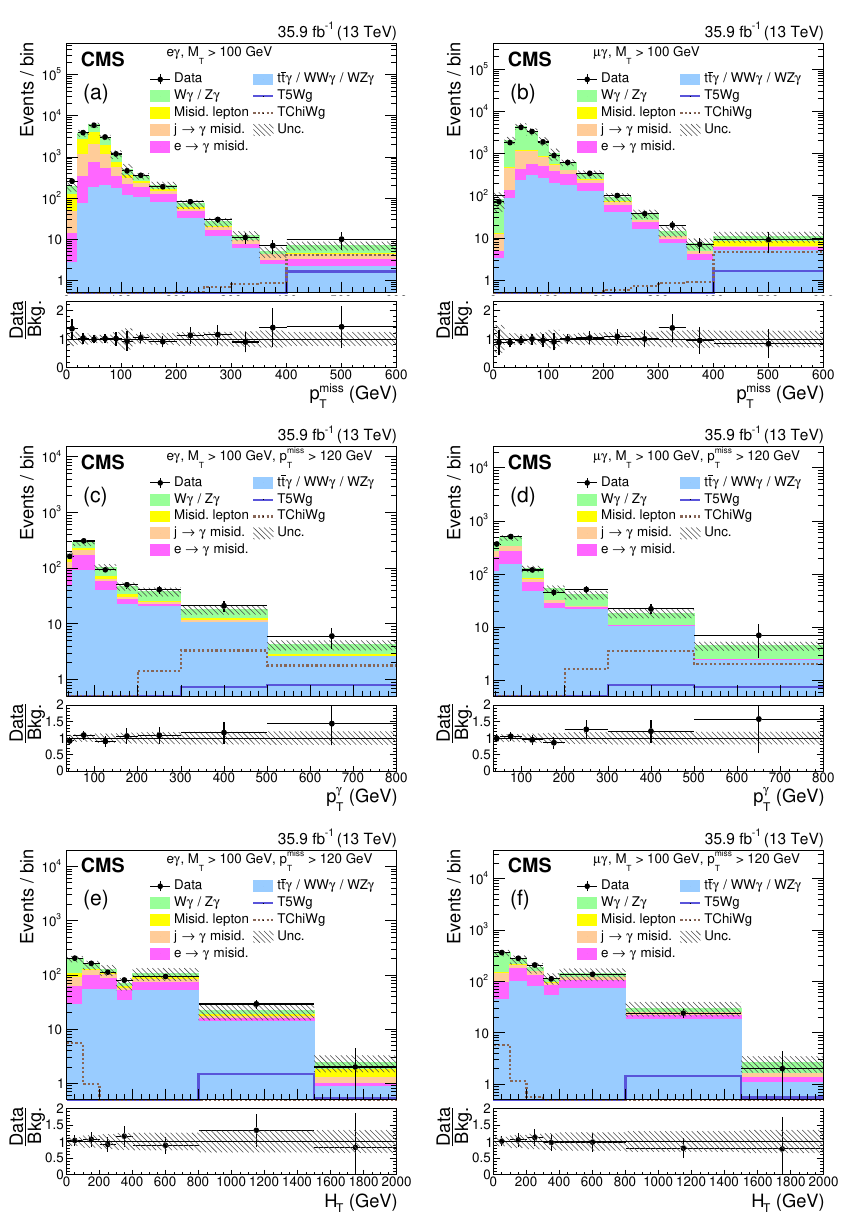
Figure 4 . Distributions of p miss (a, b), p (cid:13) (c, d), and H T (e, f) from data (points) and estimated T T SM predictions (stacked histograms) for the e (cid:13) (left) and (cid:22)(cid:13) (right) channels. Simulated signal distributions from the TChiWg model (dotted) with m = 800 GeV and the T5Wg model (solid) e (cid:31) 0 = e (cid:31) (cid:6) with m = 1700 GeV are overlaid. The p miss distribution includes all events with m T > 100 GeV, T e g while the p (cid:13) and H T distributions only include events with m T > 100 GeV and p miss > 120 GeV. T T The vertical bars on the points give the statistical uncertainty in the data and the horizontal bars show the bin widths. The hatched area represents the quadratic sum of the statistical and systematic uncertainties in the simulated background. The lower panels display the ratio of the data to the total background